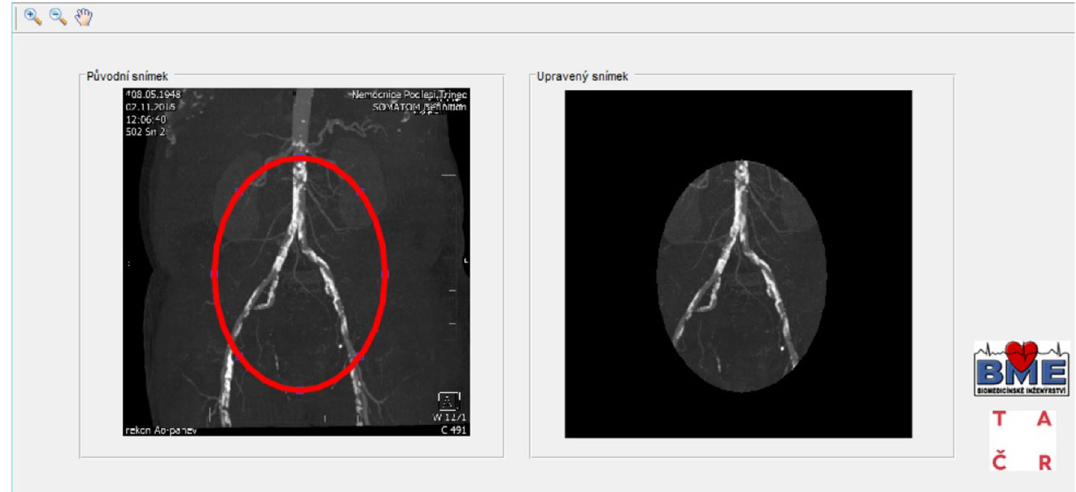
Fig. 6 Example of native image (left) and RoI